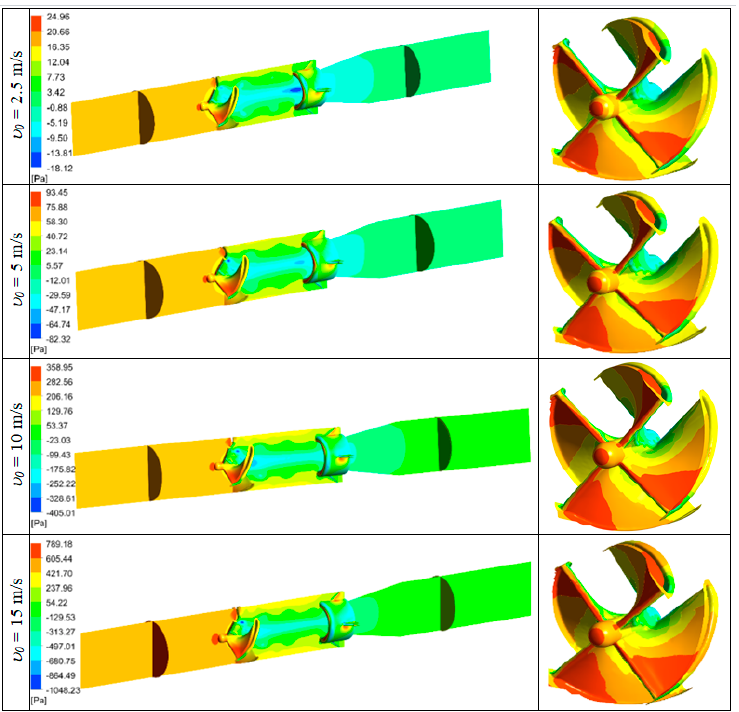
Figure 16. Pressure distribution p c (in Pa) in axial flow cyclone depending on the different inlet velocities of the cyclone υ 0.